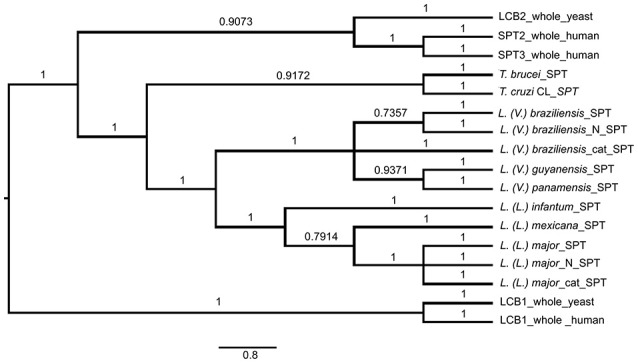
Bayesian consensus phylogeny of SPT proteins. The phylogram represents a consensus of 13 SPT sequences. The root was inferred using midpoint rooting. Posterior probabilities exceeding 0.5 are shown in the branches. The tree topology indicates that SPTs of members of Leishmania subgenus Leishmania are separated from those of Leishmania subgenus Viannia, and that SPTs of Leishmania species are separated from those of Trypanosoma brucei and T. cruzi. The scale of the generated tree (see 0.8 bar) represents the number of substitutions per sequence position. Accession numbers of SPT sequences are shown in Table 1. N, N-terminal end of protein sequence; cat, catalytic region of protein sequence.